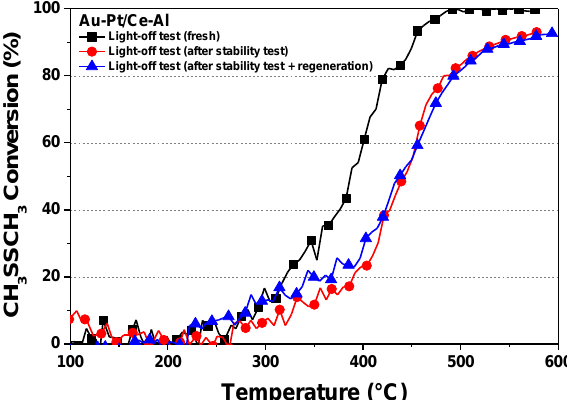
Figure 13. The DMDS conversion over Pt–Au / Ce–Al before (fresh) and after the stability test and after regeneration with air (the experimental conditions are the same as in Figure 9).